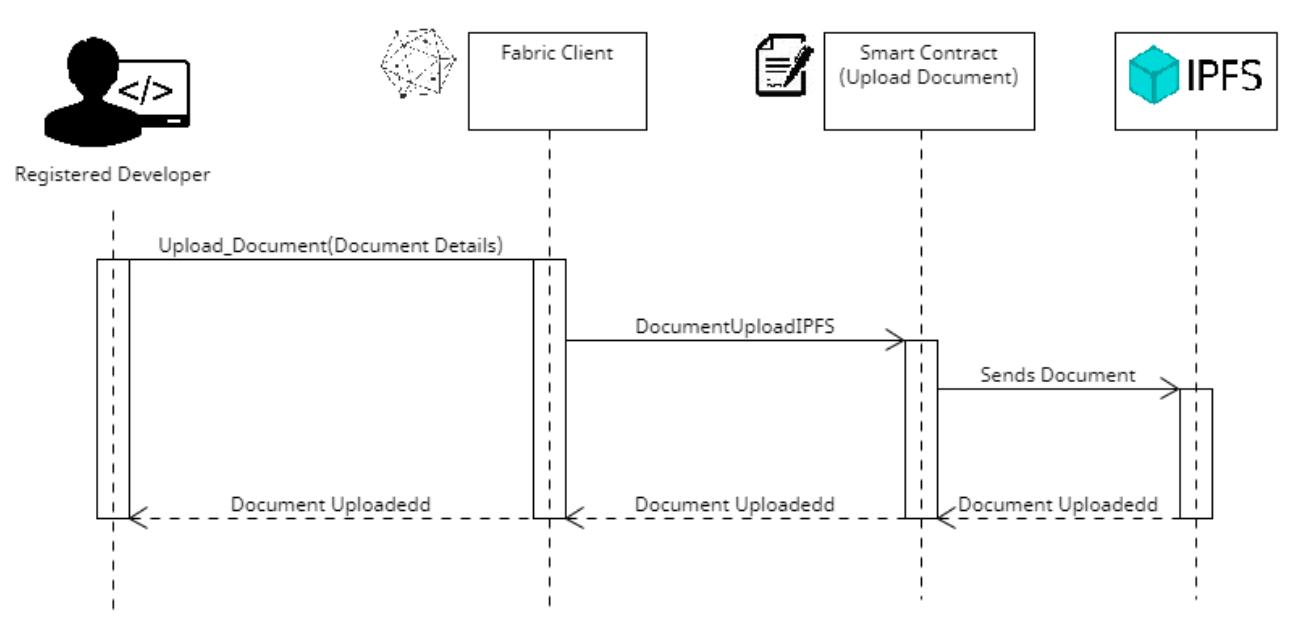
Figure 9. Upload Document SD.